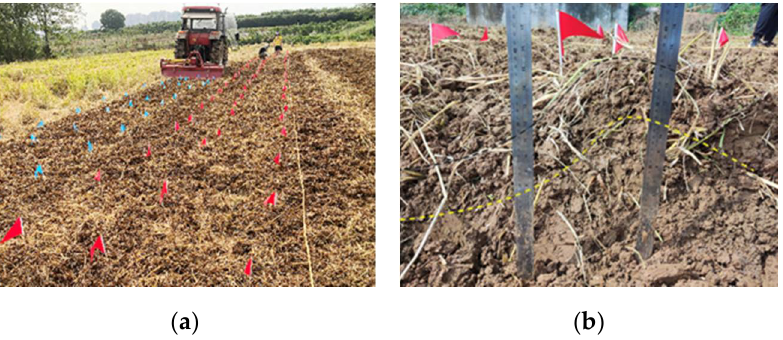
Figure 12. Field experiment effects. ( a ) Operation site of rotary burying of stubbles; ( b ) The control effect of rotating burying depth using variable-gain single-neuron PID.